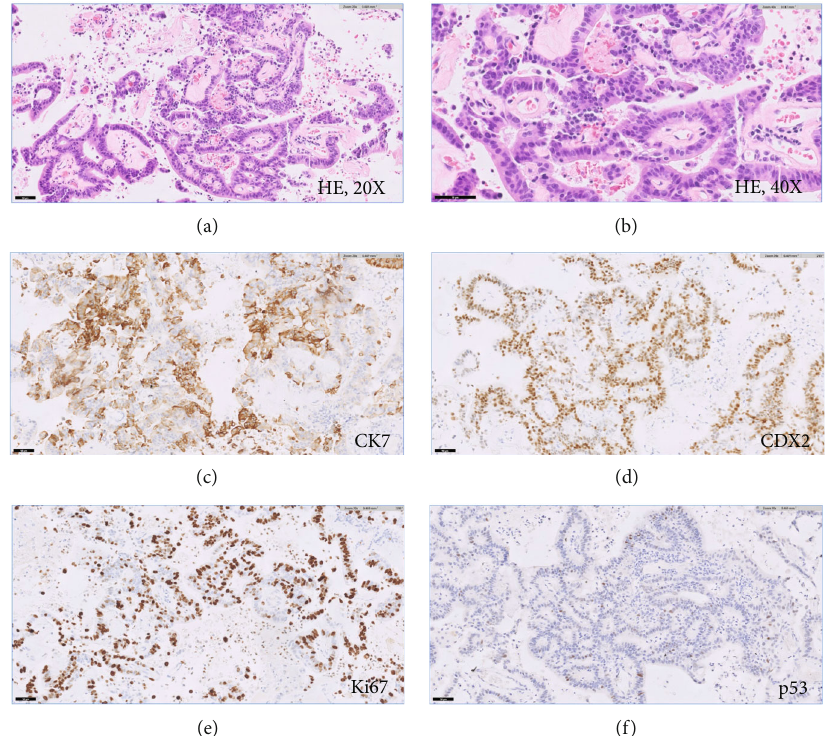
Figure 3: Proliferating glandular structures with interspersed vasculature (a); cellular atypia was appreciated at 40X magni fi cation (b). Immunostains of the atypical glandular epithelium were positive for CK7 (c) and CDX2 (d). The Ki67 proliferative index was high (e). The p53 was wild-type (f).